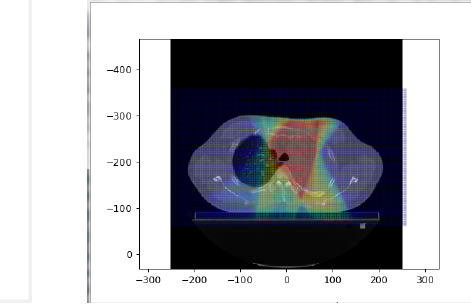
( a ) CT slice with marked lung, esophagus, and spinal cord.